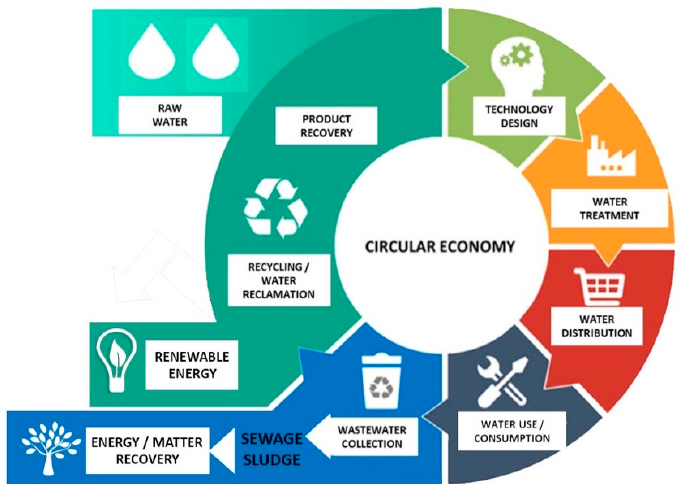
Figure 1. Circular water value chain (adapted from Zvimba’s Circular Economy model for water and wastewater management).